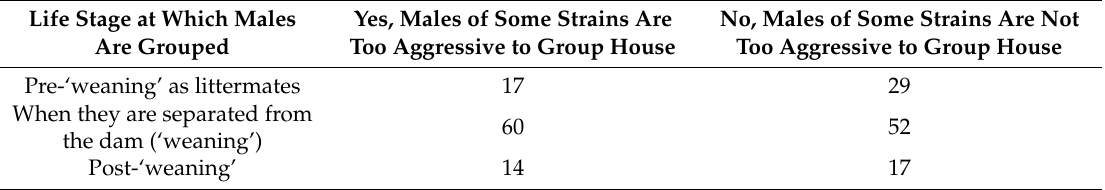
Table 2. Perceptions that some strains are too aggressive to group housing against age at grouping. Life Stage at Which Males Yes, Males of Some Strains Are No, Males of Some Strains Are Not Are Grouped Too Aggressive to Group House Too Aggressive to Group House Pre-‘weaning’ as littermates 17 29 When they are separated from 60 52 the dam (‘weaning’)